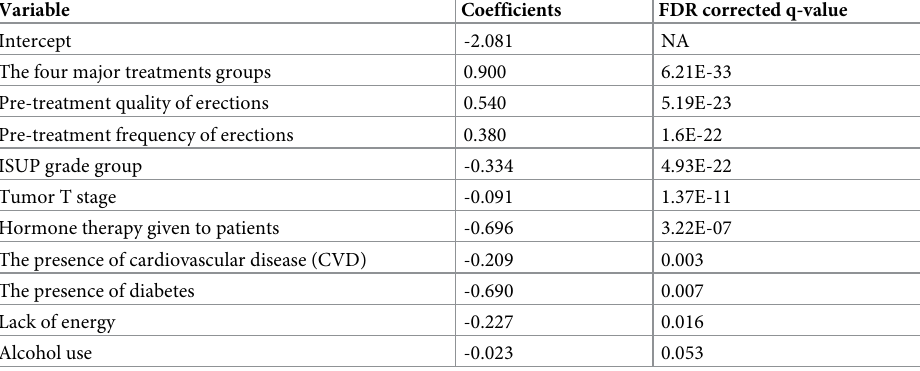
Table 2. An overview of the logistic regression coefficients for the input variables in the 1-year model. In addition, the univariate FDR-corrected q-value is reported for each variable. Variable